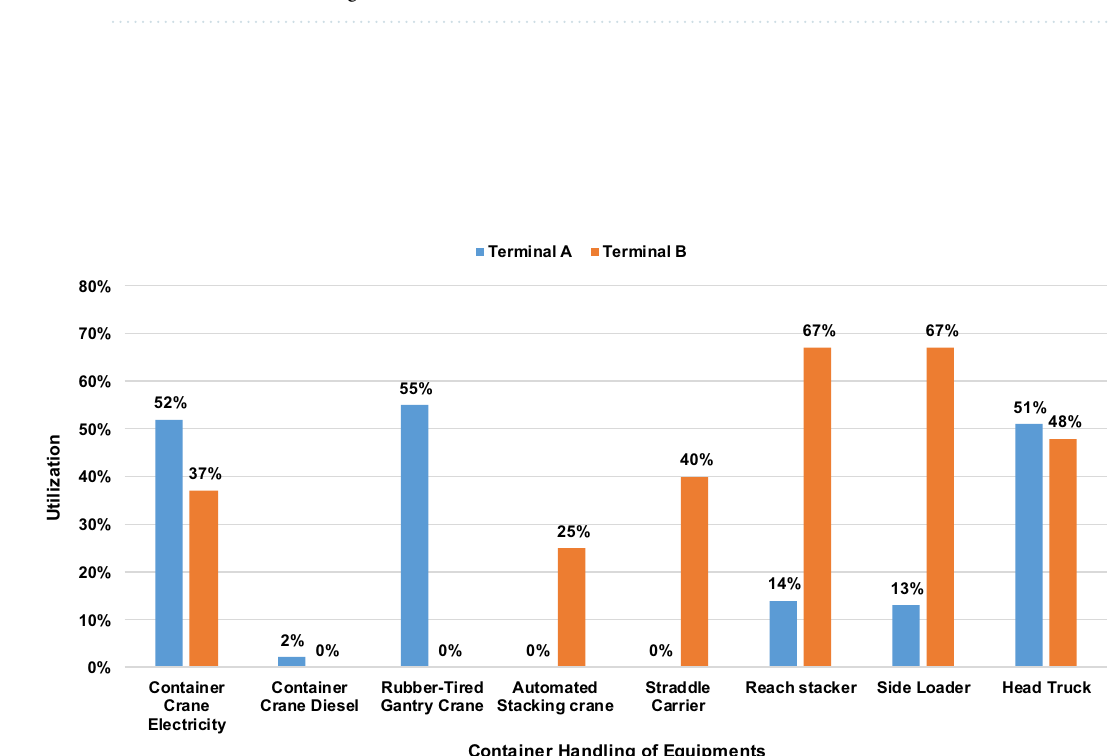
Table 3. Container-management facilities in the container terminals.